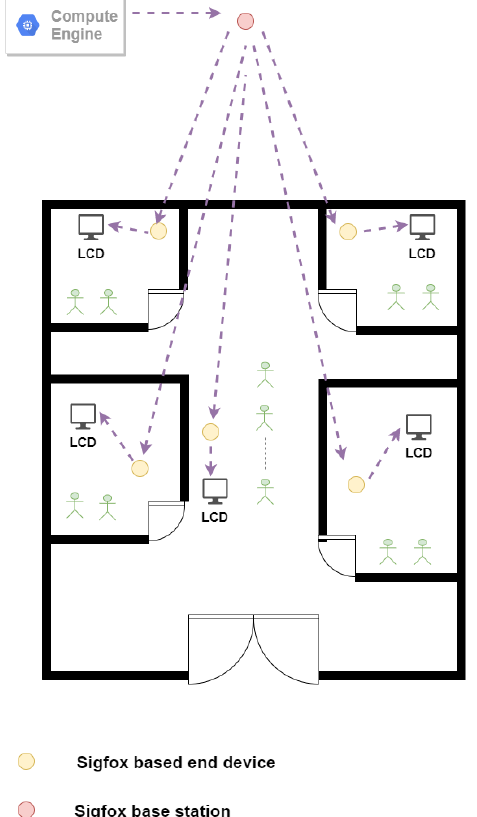
Figure 6. Case study using Sigfox technology for downlink data transmission to display on an